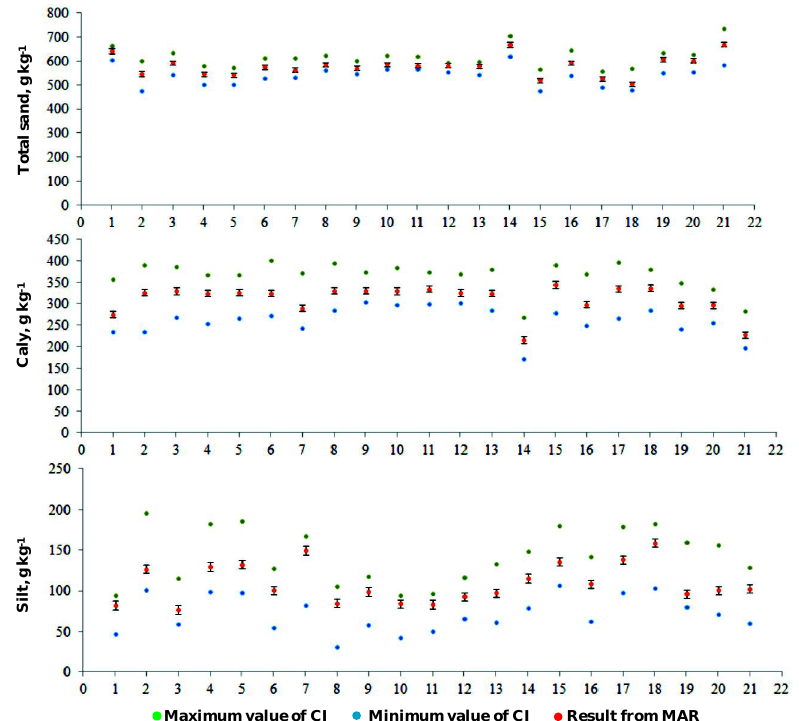
Figure 3. Accuracy analysis of 22 Medium-textured soil samples: representation of the minimum and maximum values of the confidence intervals (CI), means and average standard errors (bars) for total sand, silt and clay contents as determined by particle-size analysis using the reciprocal shaker (RSh).